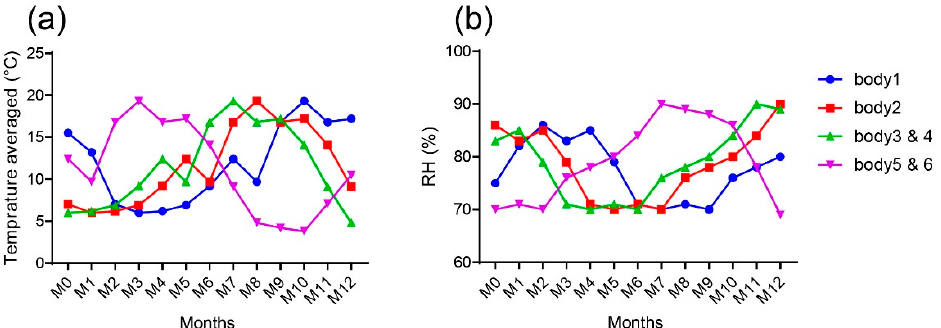
Figure 2. ( a ) Plastic bin with lid to protect from scavengers and rain; ( b ) plastic bin filled with clay soil typical of northern France carrying the rib. The rib is covered by 1 cm of soil; ( c ) ribs nos. 1 and 4 after 1 month of burial time.